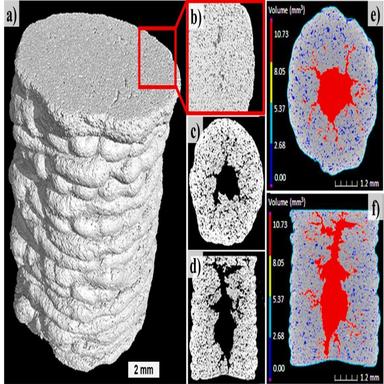
Three-dimensional (3D) virtual rendering for a representative monolithic sample obtained by µ-CT. a) overview of the sample, b) detailed view of the bottom surface, c) transverse cross-section, d) longitudinal cross-section, e) and f) pore volume distribution in color scale.